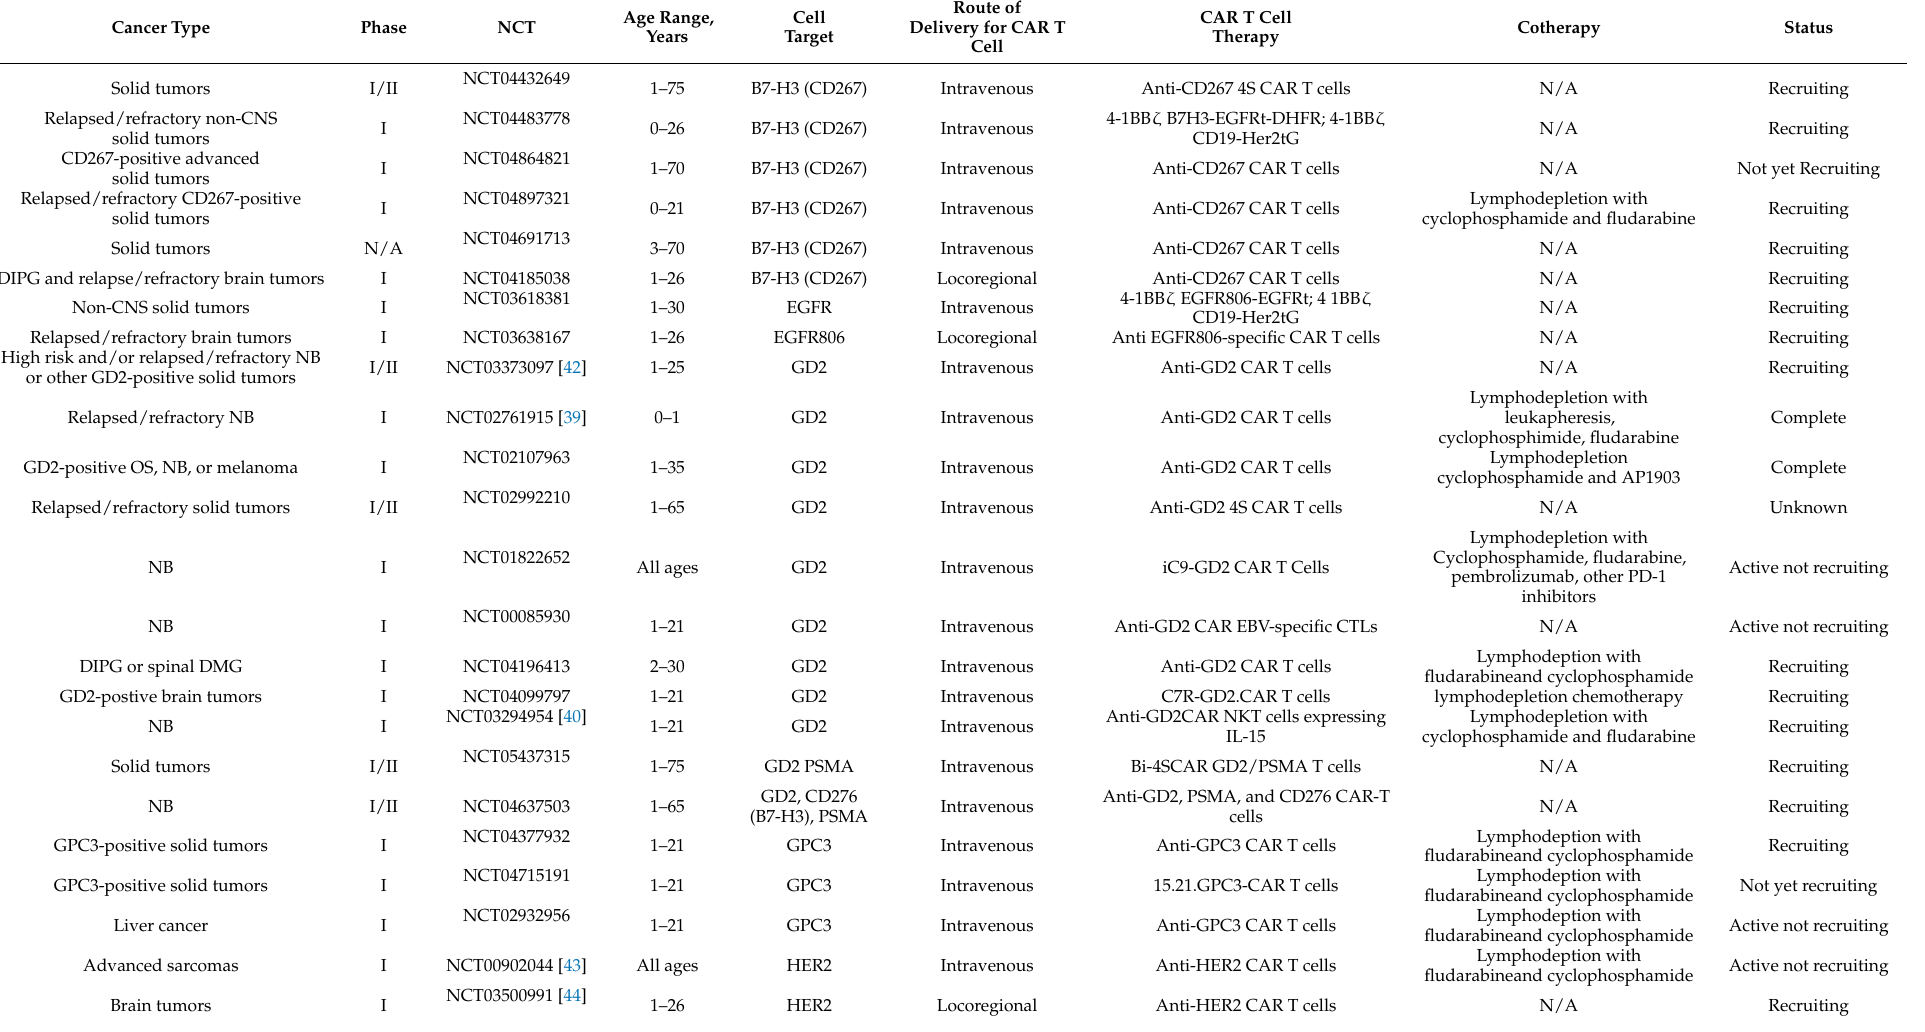
Table 1. Clinical trials of CAR T cell therapy in pediatric patients with solid